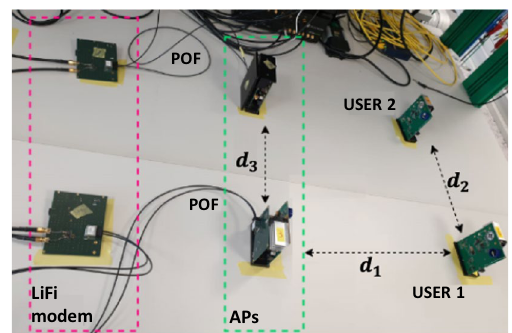
Fig. 15 Experimental set-up for LiFi D-MIMO using POF with SDM